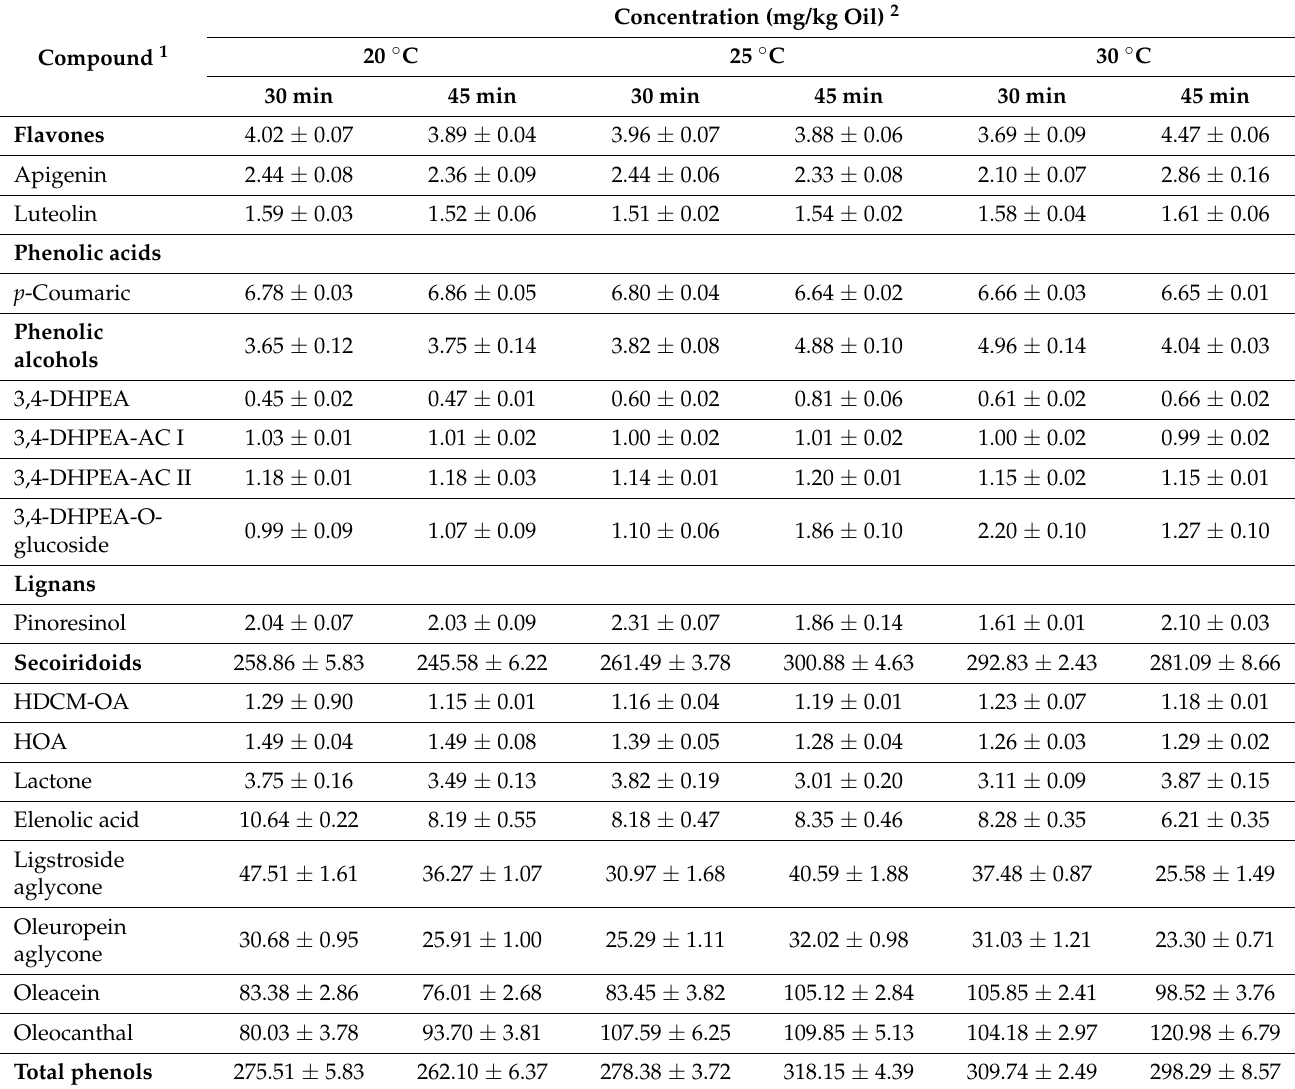
Table 2. Concentration of the phenolic compounds identified in the EVOO samples.